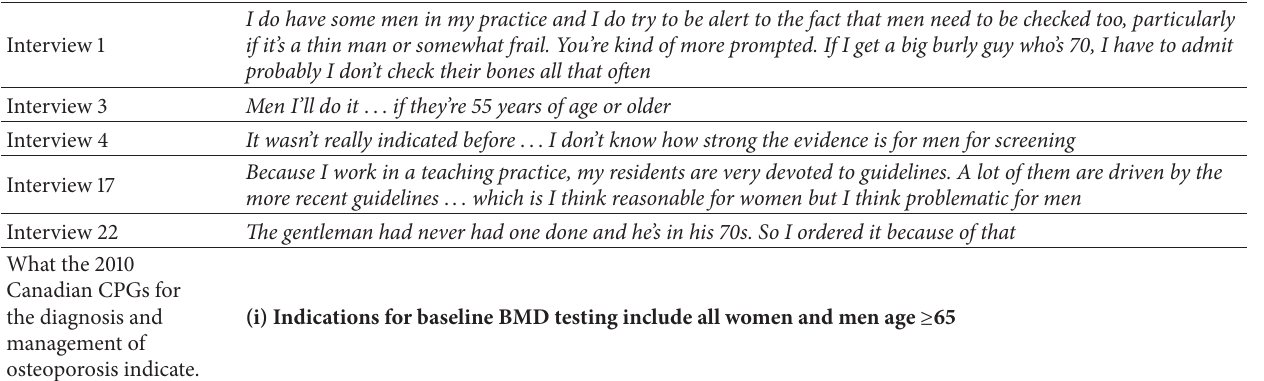
Table 2: Uncertainty about screening seniors, men in particular.